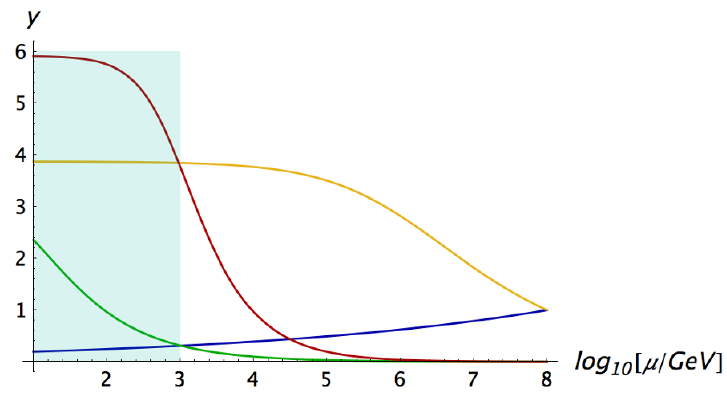
Figure 2 . Examples of the running of the mixing parameters (2.9) (the e(cid:11)ective Yukawa couplings follow similar trends), for positive (cid:13) and an order-one initial value (blue), a small negative (cid:13) and a small initial value (green), a negative (cid:13) and a small initial value (red), a negative (cid:13) and an order-one initial value (yellow). The green area shows the range of energies relevant for our analysis. The behaviour of the mixings outside the green region is not relevant for our analysis and can di(cid:11)er from what we show. For instance, all the initial values could be of order one, but the sign of the anomalous dimension could change with